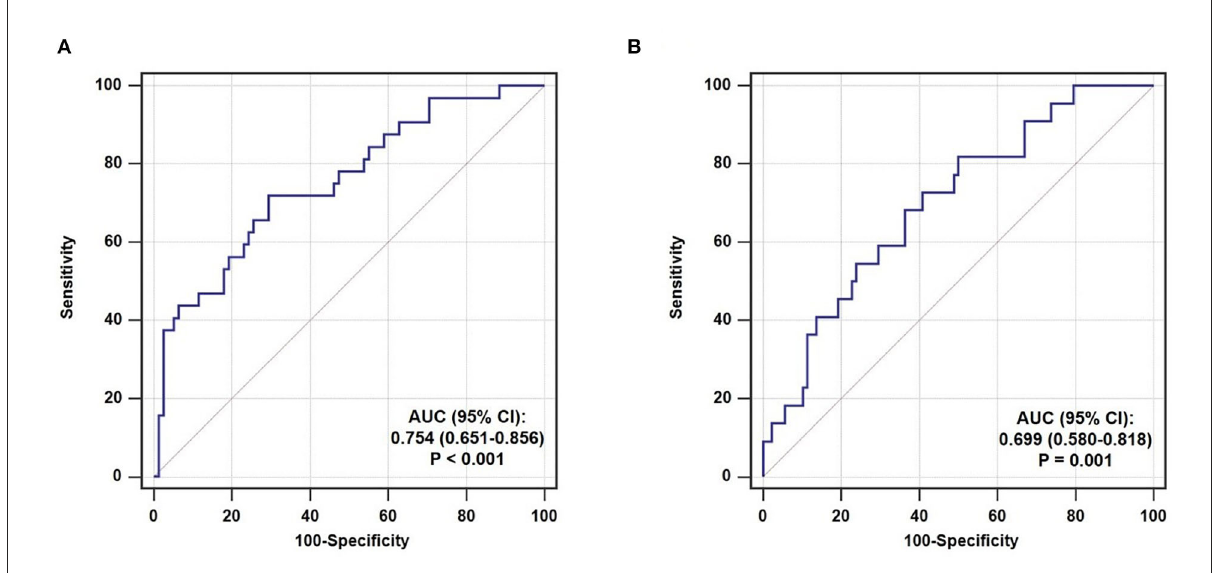
FIGURE4 ROC curve analysis evaluating the predictive ability of TyG index for non-culprit (A) TCFA and (B) ruptured plaque. AUC, area under the ROC curve; CI, confidence